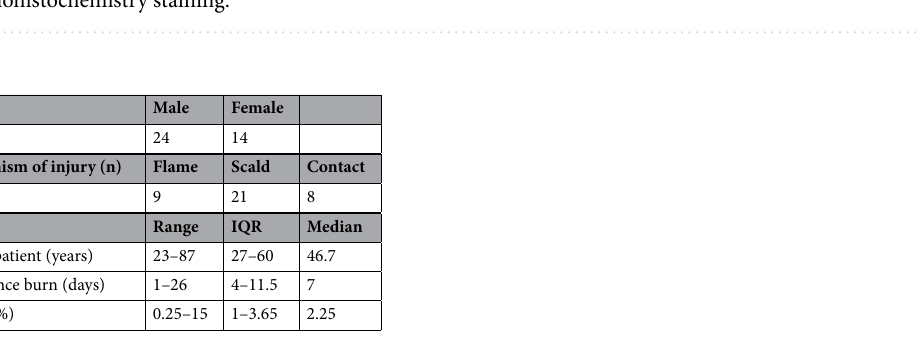
Table 2. Summary of recruited patients. Summary of patient demographics. Note the commonest injury type was a scald injury, more males than females were recruited with a broad range of patient age, time since injury and relatively low total body surface area (TBSA) percentage. During surgical intervention, tissue biopsies were taken from burn and control wound.